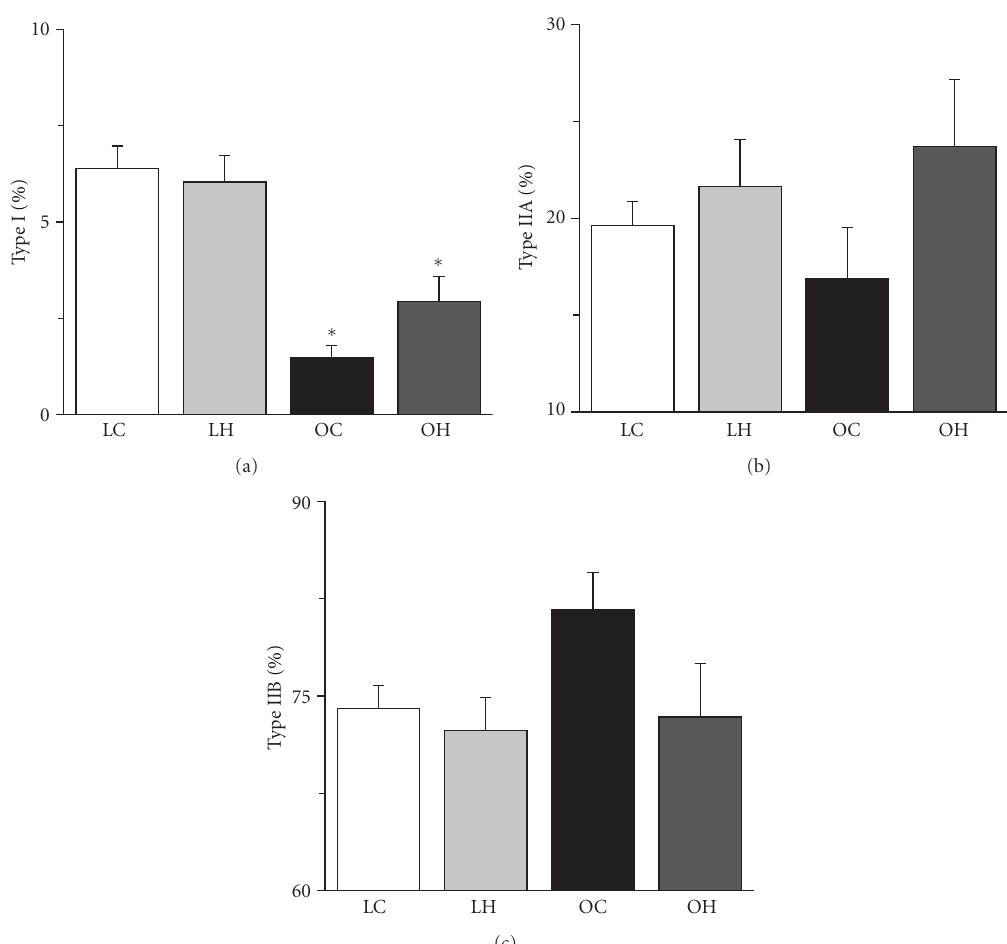
Figure 3: Distribution of type I (a), IIA (b), and IIB (c) fibers in the extensor digitorum longus muscle. The values of fiber-type distribution are presented as the mean ± SEM. ∗ is significantly di ff erent from the LC and LH groups at P < 0 . 05. The measuring field was set over the entire muscle